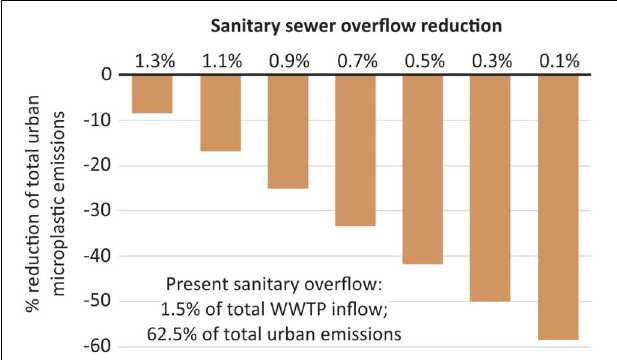
FIGURE 7 | Micro-plastic particle emission reductions (floating and sinking fraction, size class 20–500 µ m) resulting from the assumption that instead of todays 1.5% sanitary sewer overflow (of the total annual WWTP inflow) in the Baltic catchment, technical retention measures reduce the overflow share stepwise to 0.1% of the total wastewater amount.